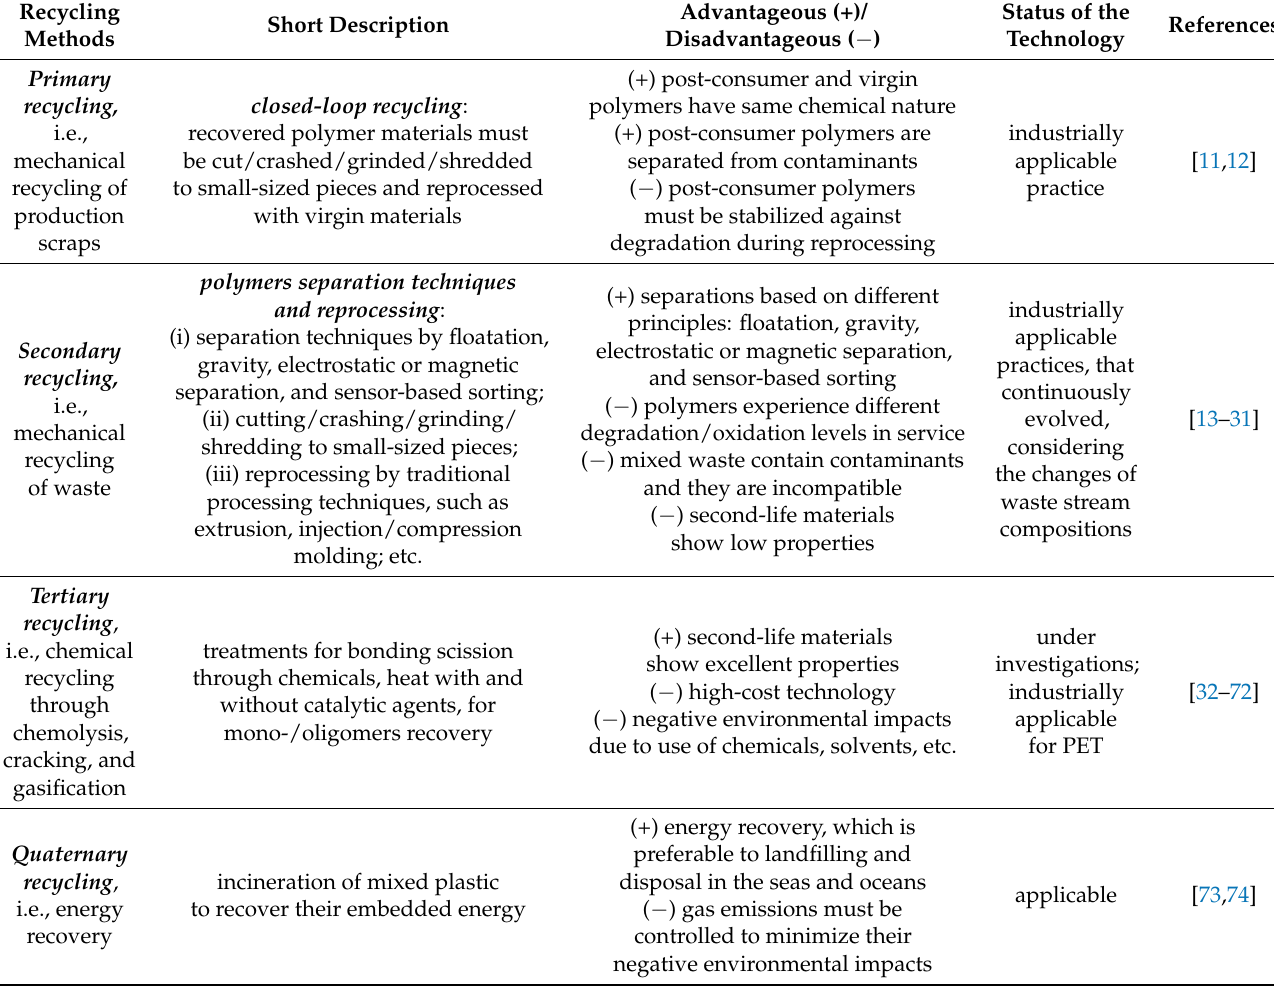
Table 1. Overview of recycling methods for thermoplastic